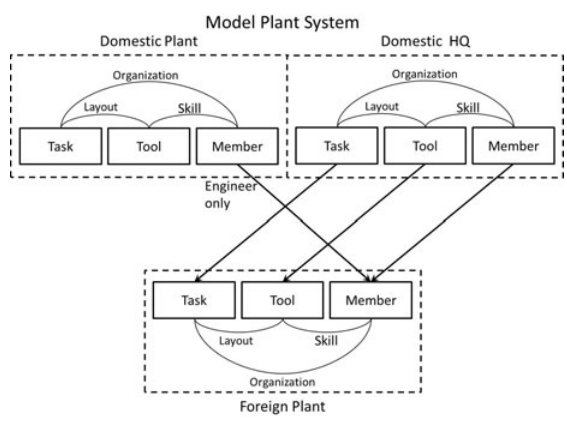
Figure 2. Knowledge transfer of model plant